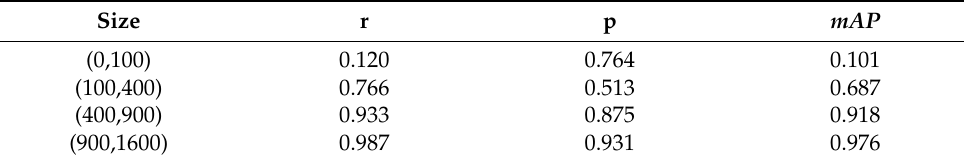
Table 3. Evaluation results of targets in different scales in LS-SSDD-v1.0 using SII-Net. Size r p